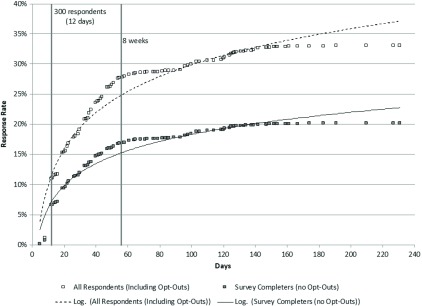
Survey response rate over time (n = 4823). Note: Respondents with no survey return date are not shown, n = 18.